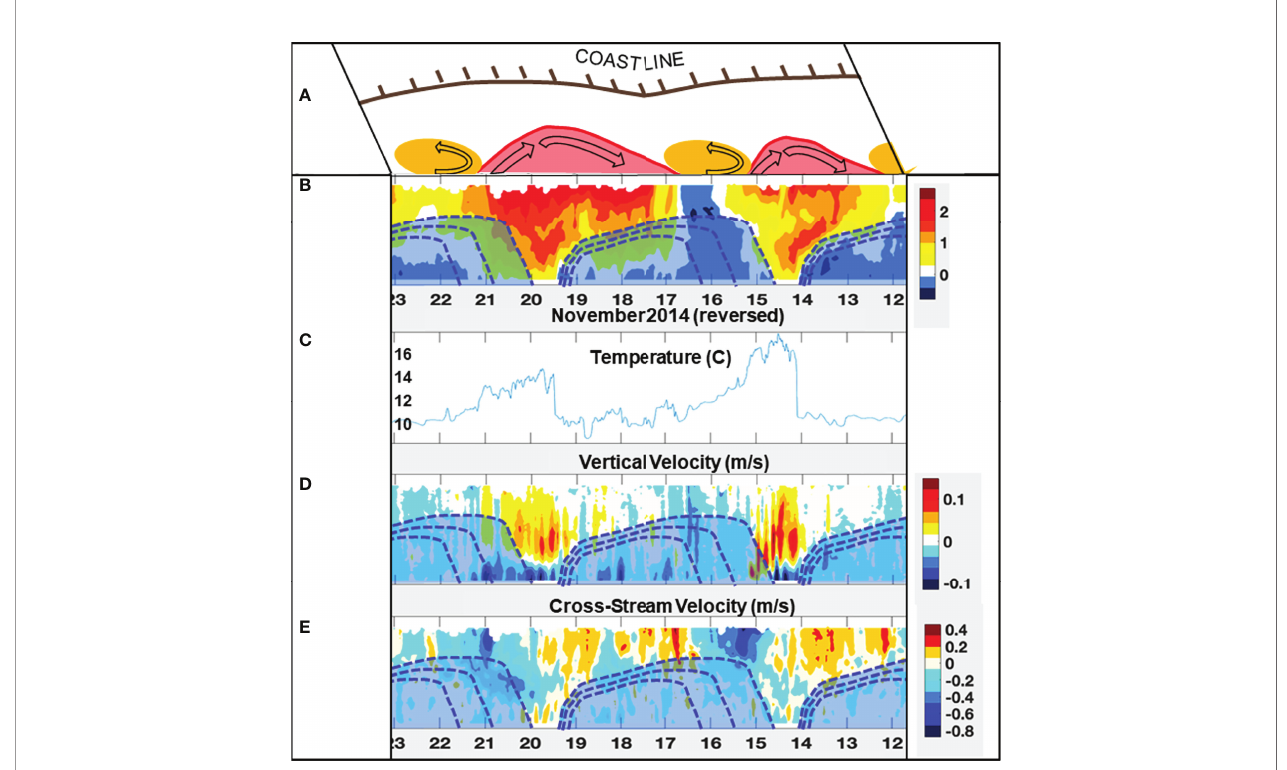
FIGURE 14 | A 3-D view of meander spatial structure, utilizing the ADCP time series from November 12 to 23. The time series have been reversed (right to left) to allow the data to be plotted as a function of downstream distance, assuming a constant downstream propagation speed. Two warm Gulf Stream meander crests and three cool cyclonic frontal eddies are shown schematically on the top horizontal surface (A) . Panel (B) is the downstream velocity component (positive to the right), (C) is bottom temperature (at the ADCP), (D) is the vertical velocity component, and E is the cross-stream velocity component (positive into the page, which is towards the coast). Three schematic cold domes in the meander troughs have been added (shaded light blue). The dashed contours are assumed